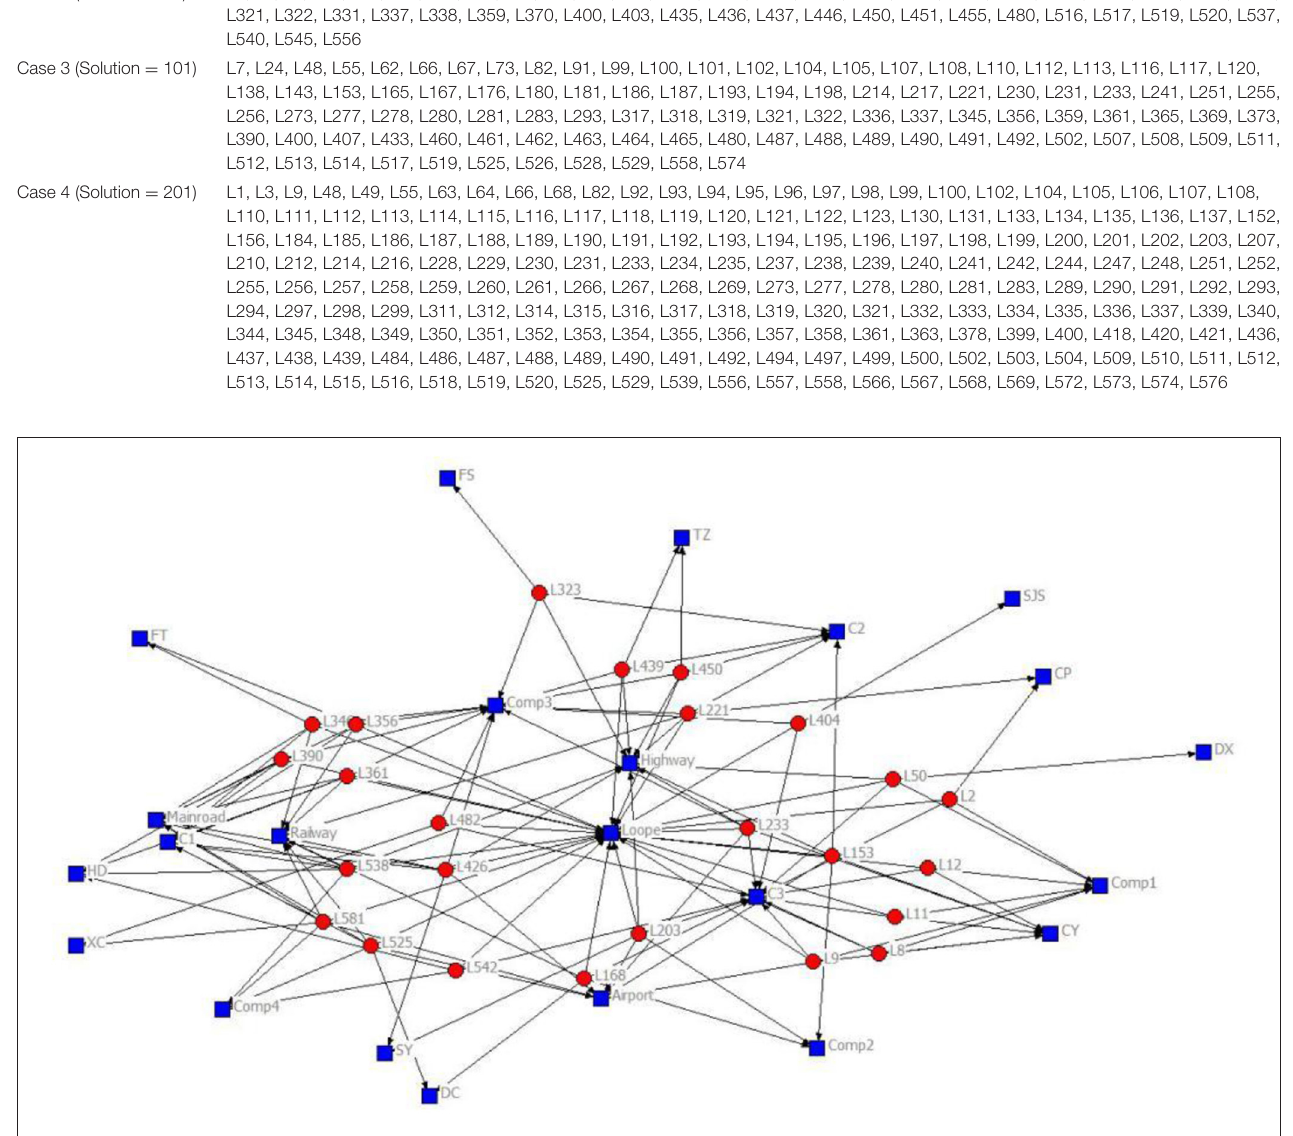
FIGURE 1 | 2-Mode Network of Distribution centers and Local Conditions in the Heuristic Solution of Case 1 (Solution =